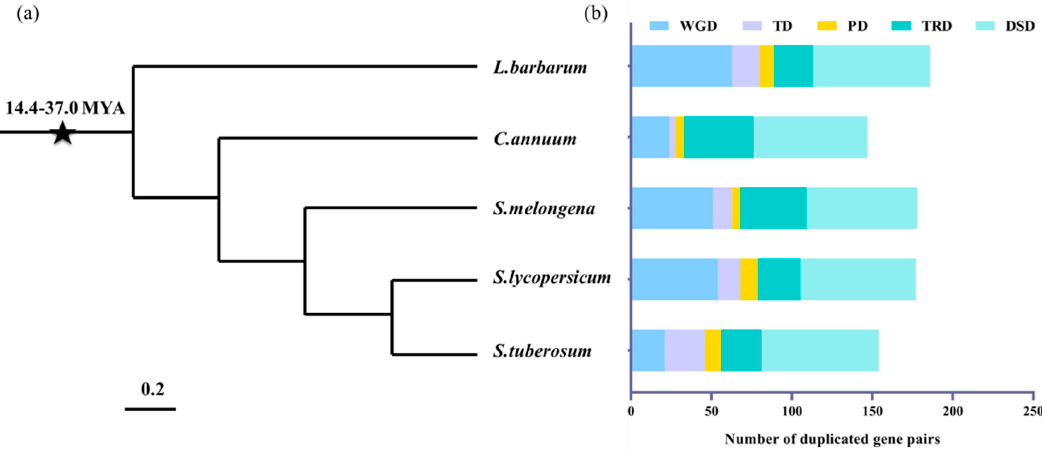
Figure 3. The number of R2R3-MYB gene pairs derived from different gene duplication events in the five Solanaceae species. ( a ) The phylogenetic relationship among the five Solanaceae species. ( b ) The number of different models of duplicated gene pairs in each species. The x-axis represents the number of duplicated gene pairs. The y-axis represents species. Whole-genome duplication (WGD), tandem duplication (TD), proximal duplication (PD), transposed duplication (TRD), and dispersed duplication (DSD).